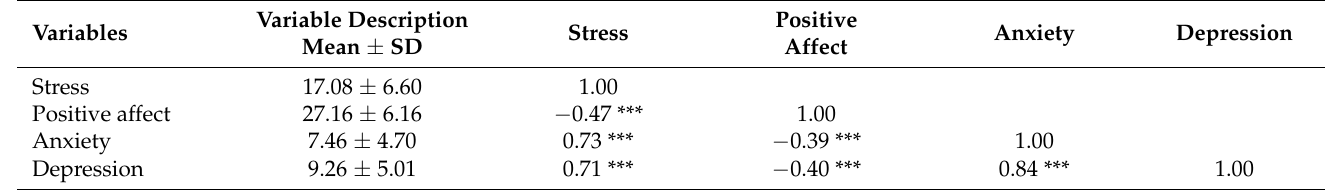
Table 2. Description and Correlations of key variables ( N = 644).